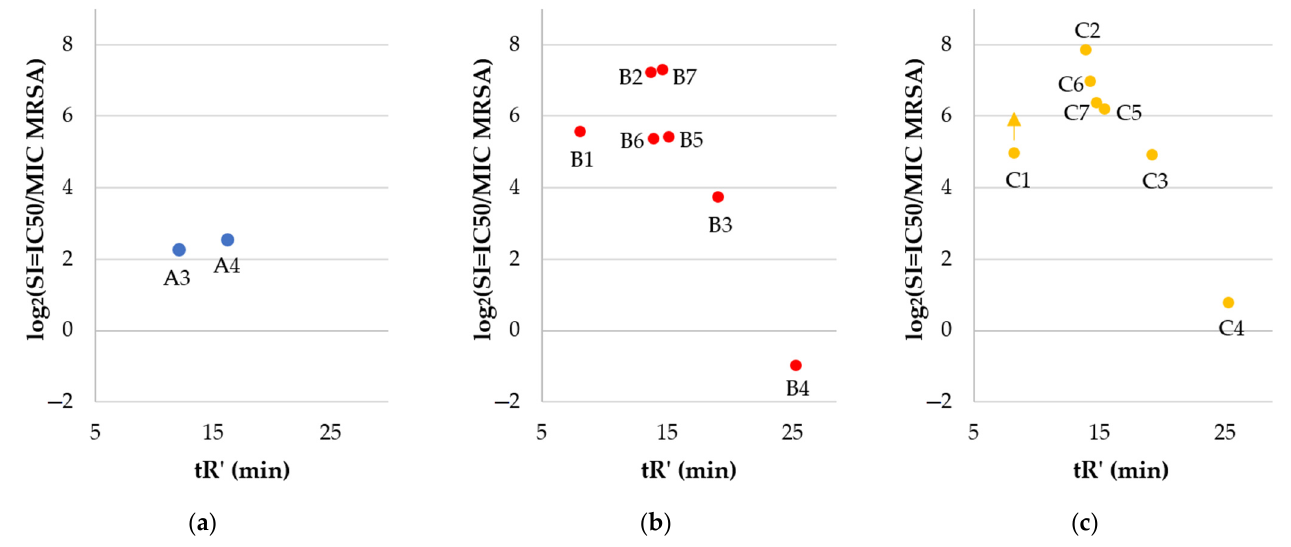
Figure 8. The log 2 of selectivity indexes of surfactants vs. adjusted retention time (tR’): Cytotoxicity (IC 50 ) vs. adjusted retention time (tR’): ( a ) USCL—parent molecules (series A ); ( b ) gemini lipopeptides with L-lysine amide spacer (series B ); ( c ) gemini lipopeptides with L-cystine diamide spacer (series C ). The selectivity included IC 50 HaCaT and MIC of compounds against MRSA (Methicillin-resistant Staphylococcus aureus , ATCC 33591). Arrows indicate that IC 50 is above the applied concentration range.